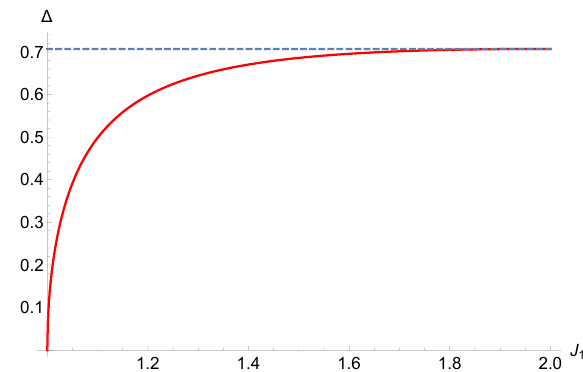
, ∆ ) is above the red line. Below 1